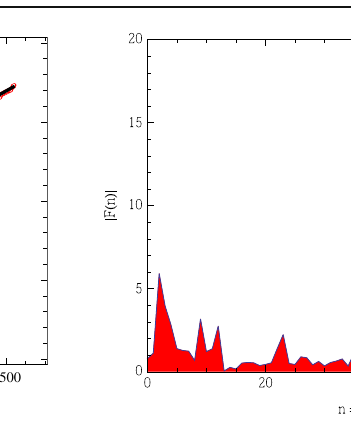
Fig. 3 Fourier analysis of the combined residuals of LARES, LAGEOS and LAGEOS 2 removing a constant trend, over about 7 years of orbital observations. In the horizontal axis is the frequency times 2534 days. In the vertical axis is the absolute value of the Dis- crete Fourier Transform | F ( n ) |